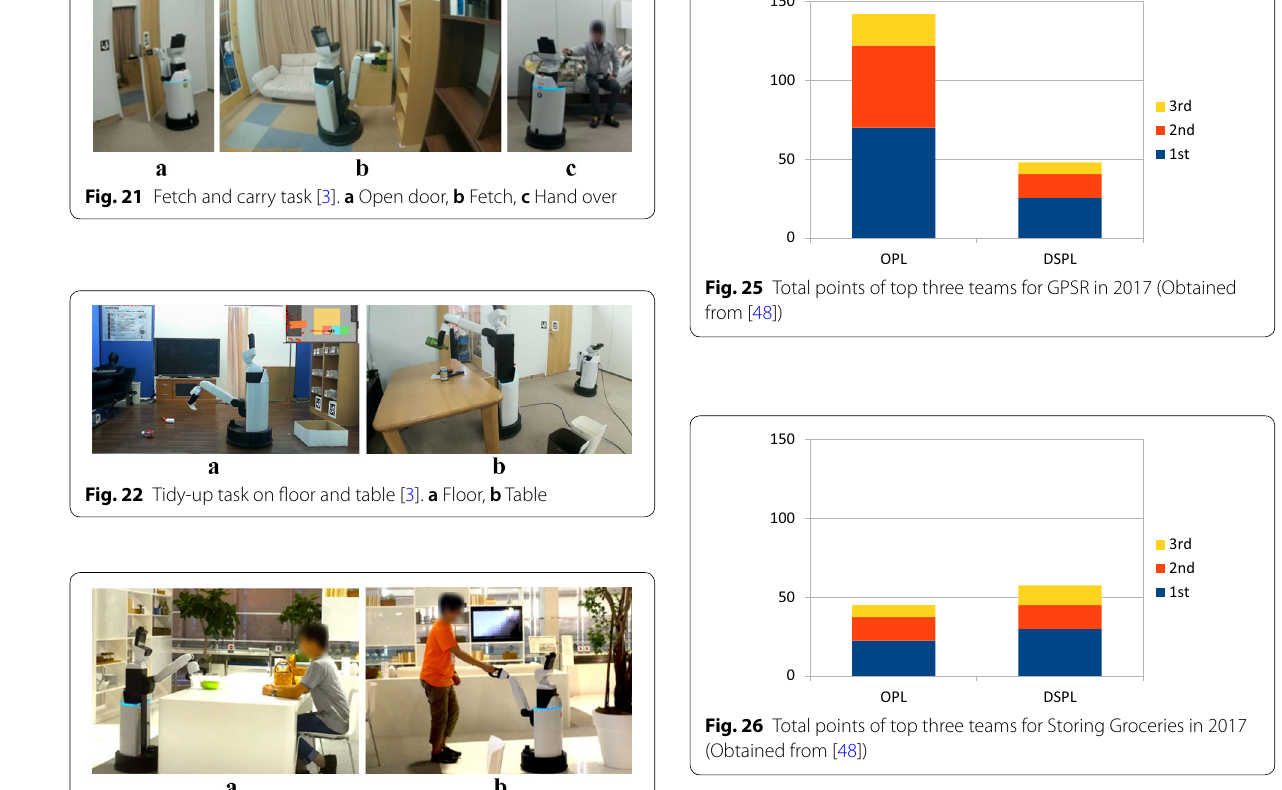
Fig. 23 Examples of HSR hackathon demonstration. a Cooking task, b Dancing with HSR